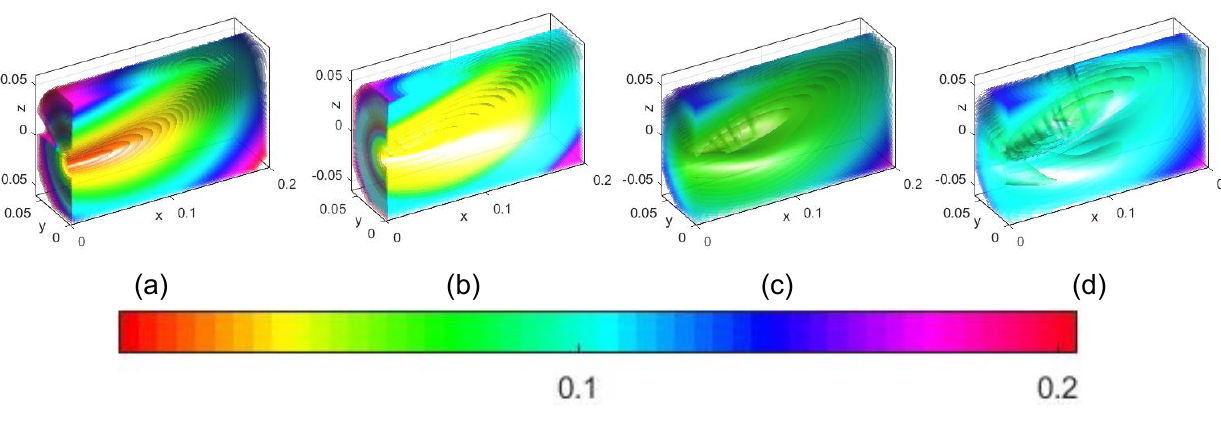
Figure 8. The PEFs of the variant U-section and 0 ◦ material orientation, with a progressive prestress angle show that the lowest energy “bubble” drifts away from the main plane. The applied angle is (a) 0, (b) θ c , (c) 1.5 θ c , and (d) 2 θ c . The critical angle in present variant is θ c = 0 . 268rad, as can be found in Table